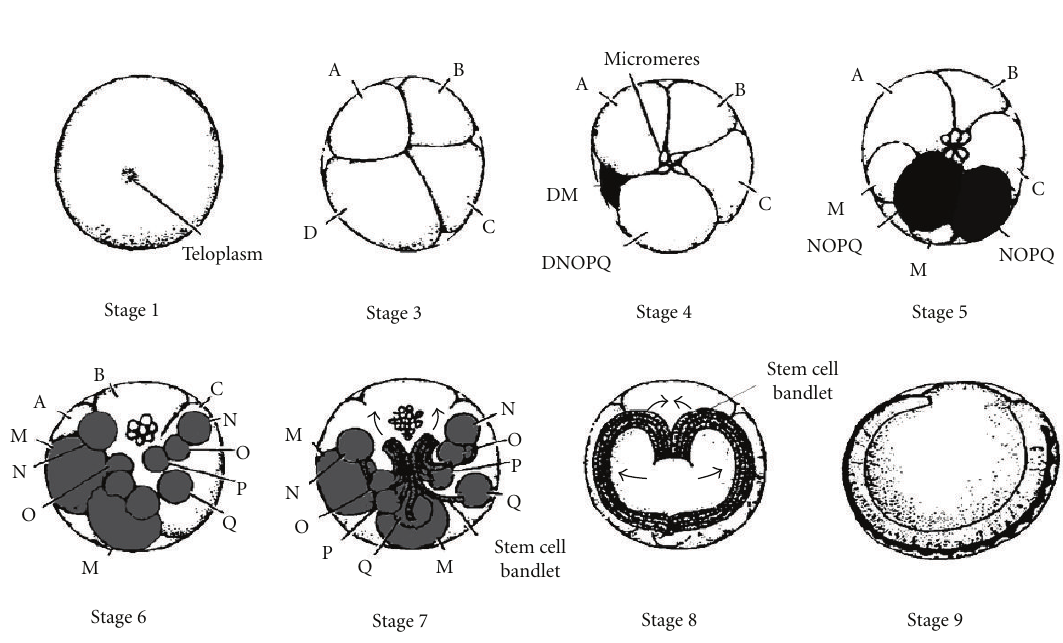
Figure 1: Schematic of early development in glossiphoniid leeches. After several asymmetric cleavages, proteloblasts DM (stage 4) and NOPQ (stage 5) are stereotypically positioned on the embryo’s surface. A series of unequal divisions leads to five bilaterally paired stem cells (10 total), or teloblasts (gray cells: M, N, O, P, Q), that give rise to chains of segmental founder cells called bandlets (stages 7, 8). By epiboly, bandlets move across the surface of the embryo (arrows, stage 8) and coalesce to form the segmental mesodermal and ectodermal tissue. Modified from Hohenstein and Shain